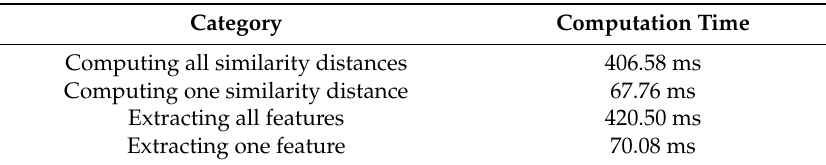
Table 4. Computation time for recognizing emotional